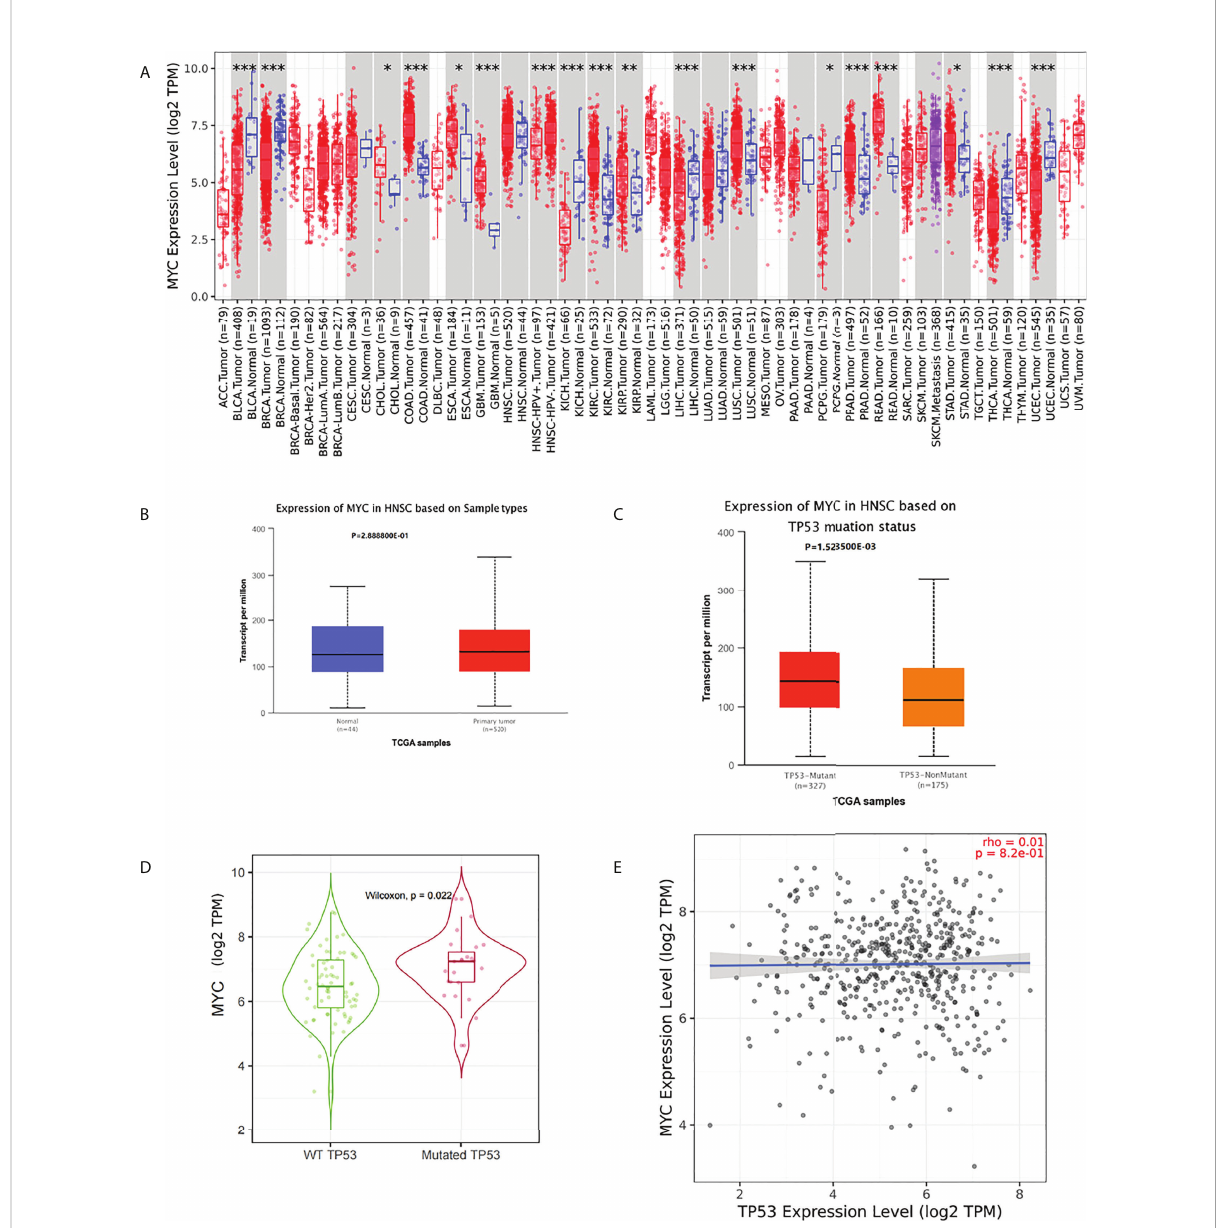
FIGURE 1 (A) c-Myc mRNA expression in pancancer (*: p-value < 0.05; **: p-value <0.01; ***: p-value <0.001). (B) c-Myc mRNA expression in HNSC (UALCAN). (C) c-Myc mRNA expression based on TP 53 mutation status (UALCAN). (D) c-Myc mRNA expression based on TP 53 mutation status (TIMER2.0). (E) Correlation between MYC and TP53 expression (TIMER2.0Fig